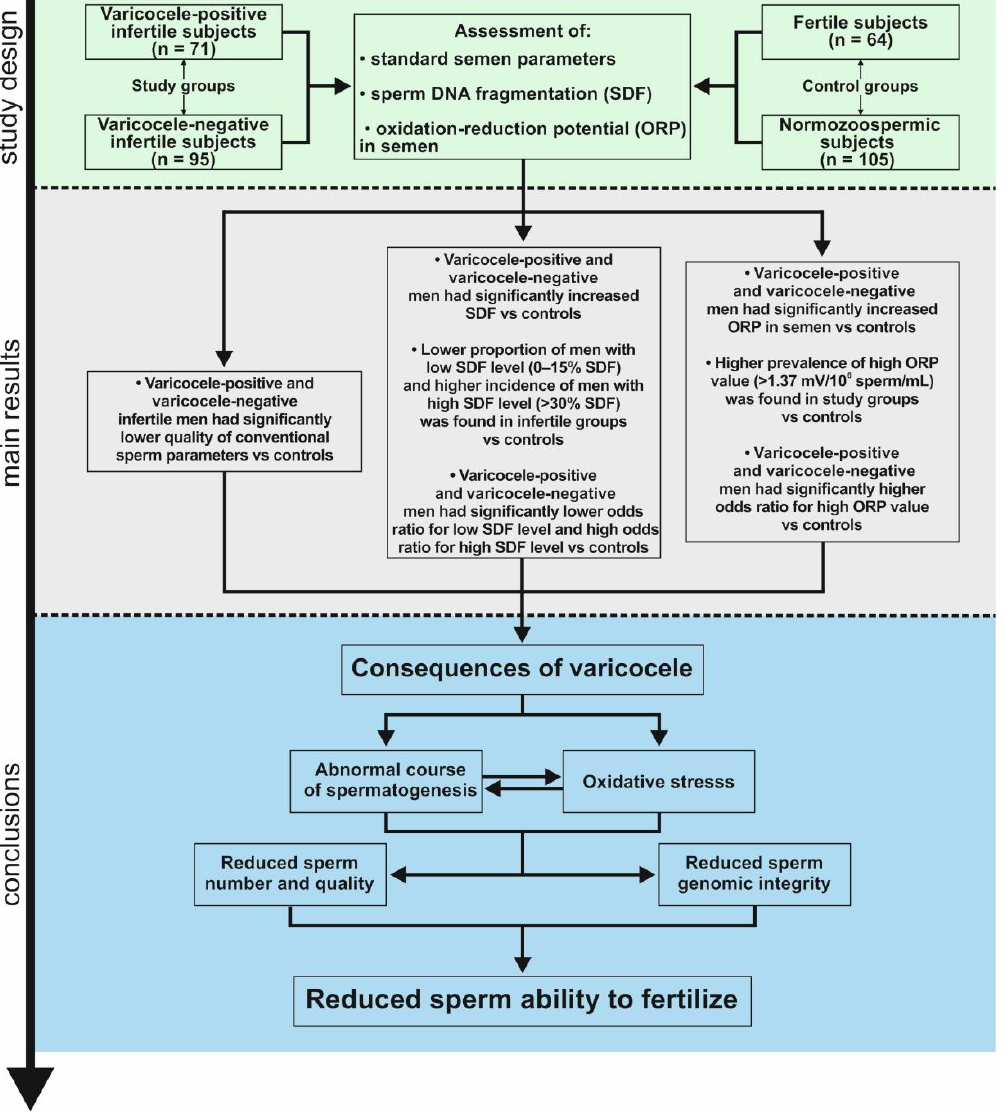
Figure 1. Study design, results and suggested pathomechanism associated with abnormalities of spermatogenesis in varicocele subjects.